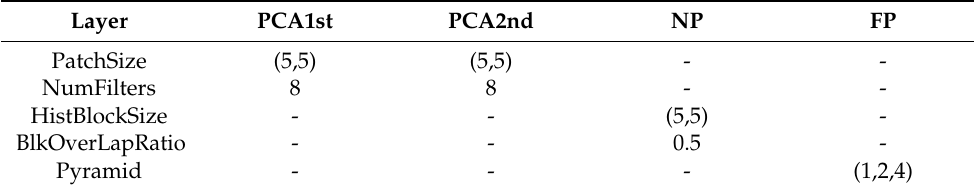
Table 3. Network structure of the Bohai Bay data set.